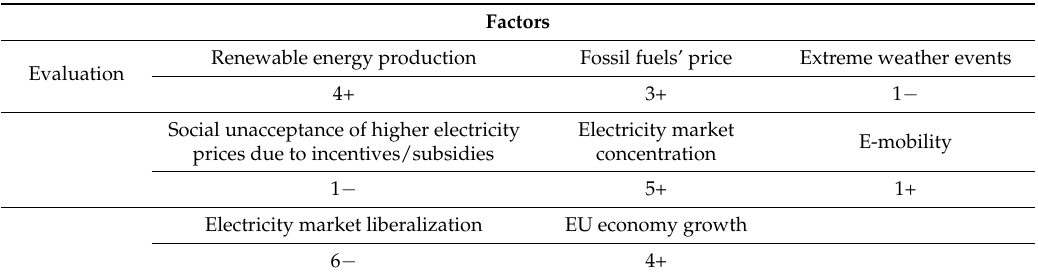
Table 4. External factors having an influence on the future electricity market evolution.